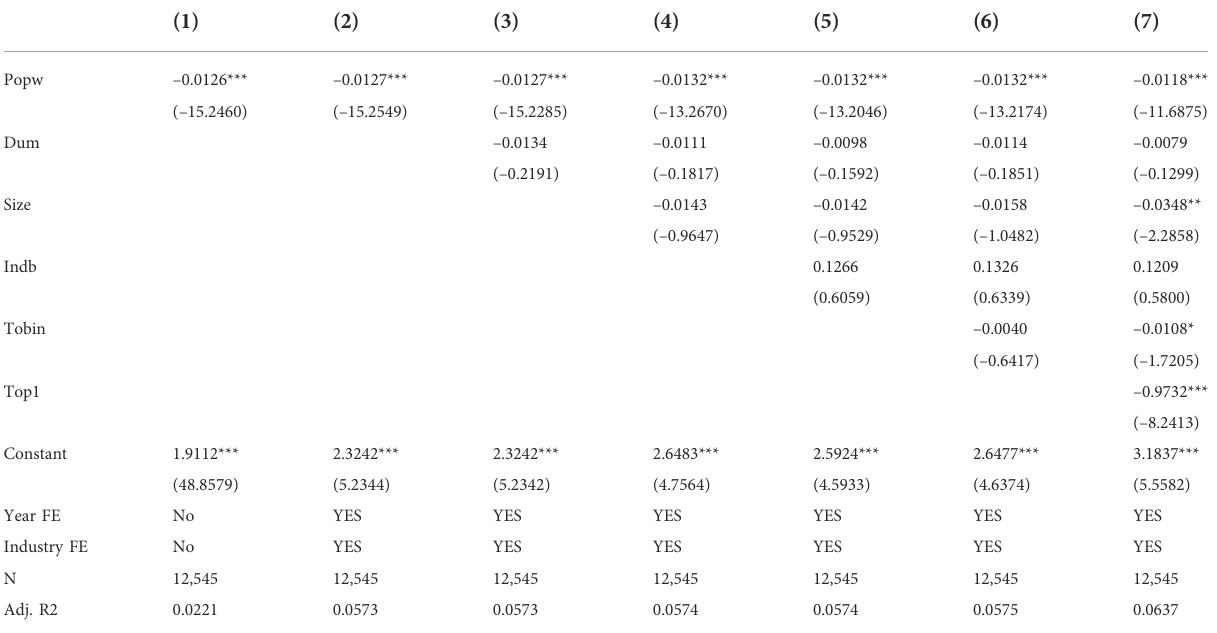
TABLE 3 Regression results for benchmark model.